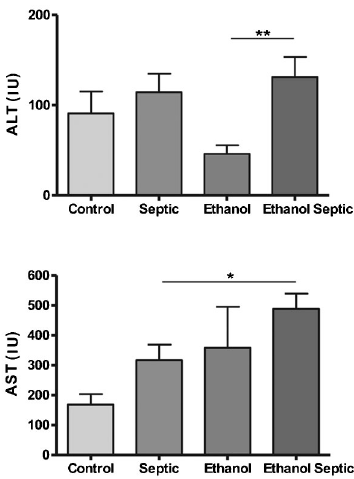
Figure 3. Alanine aminotransferase (ALT) and aspartate amino- transferase (AST) levels were increased in animals exposed to ethanol and subjected to sepsis. Control (n=12) and septic (n=20) groups received water, and ethanol (n=12) and ethanol septic (n=25) groups received 10% ethanol solution for 4 weeks. Septic and ethanol septic groups underwent septic procedure while control and ethanol groups received normal saline injected intraperitoneally. Whole blood was obtained by cardiac